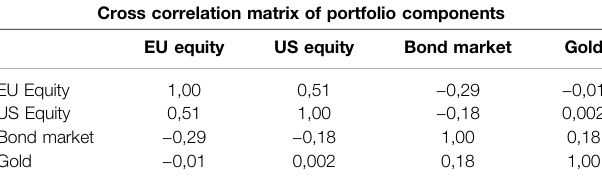
TABLE 3 | Cross correlation matrix of portfolio